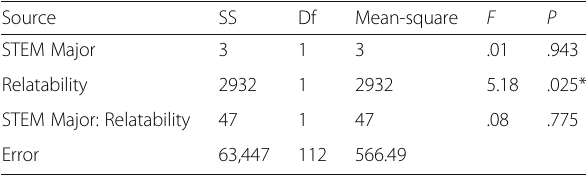
Table 1 Two-Way ANOVA Testing Peer Leader Relatability and Student Major on Student Perceived Learning